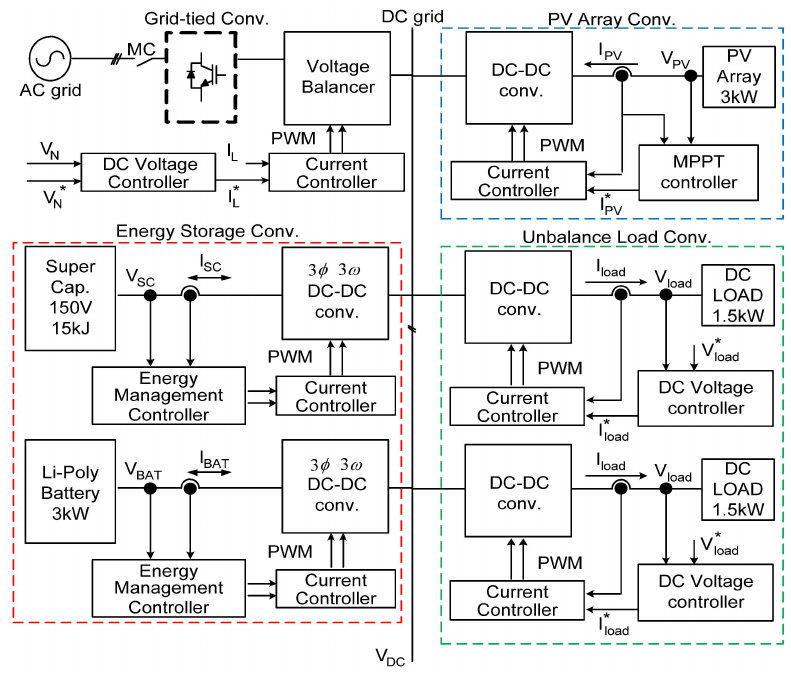
Figure 3. Power converter